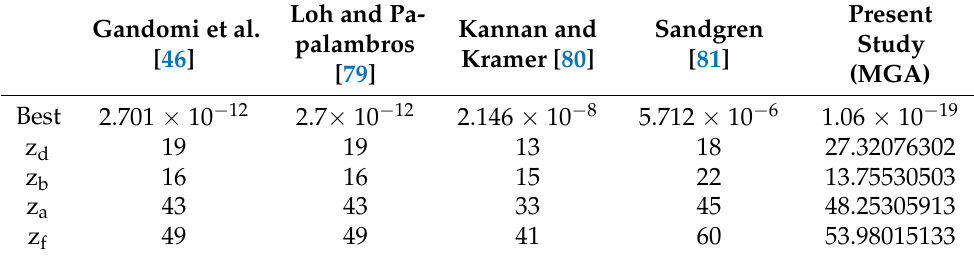
Table A17. Comparison of the best solutions for the gear train design problem.